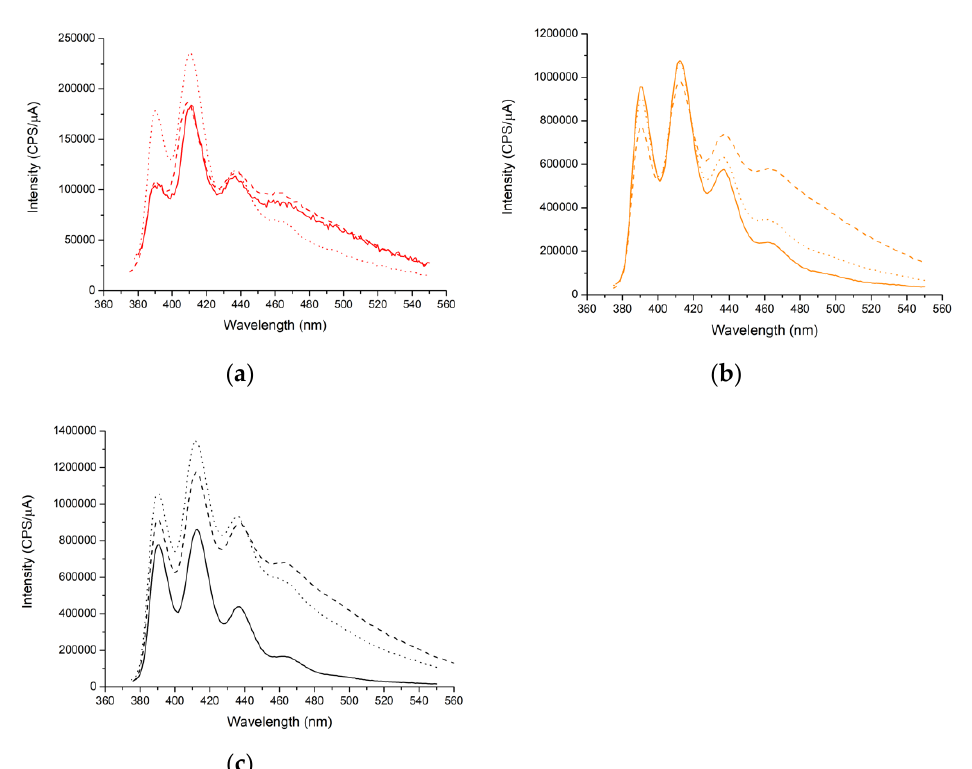
Figure 8. Emission spectra of [Mn II ]@NP for each NP type (full line) compared to the emission spectra of the supernatant after centrifugation (dashed line) and the filtrate (dotted line): ( a ) 5-[Mn II ]@RSNP, ( b ) 5-[Mn II ]@SNP and ( c ) 5-[Mn II ]@CSNP.